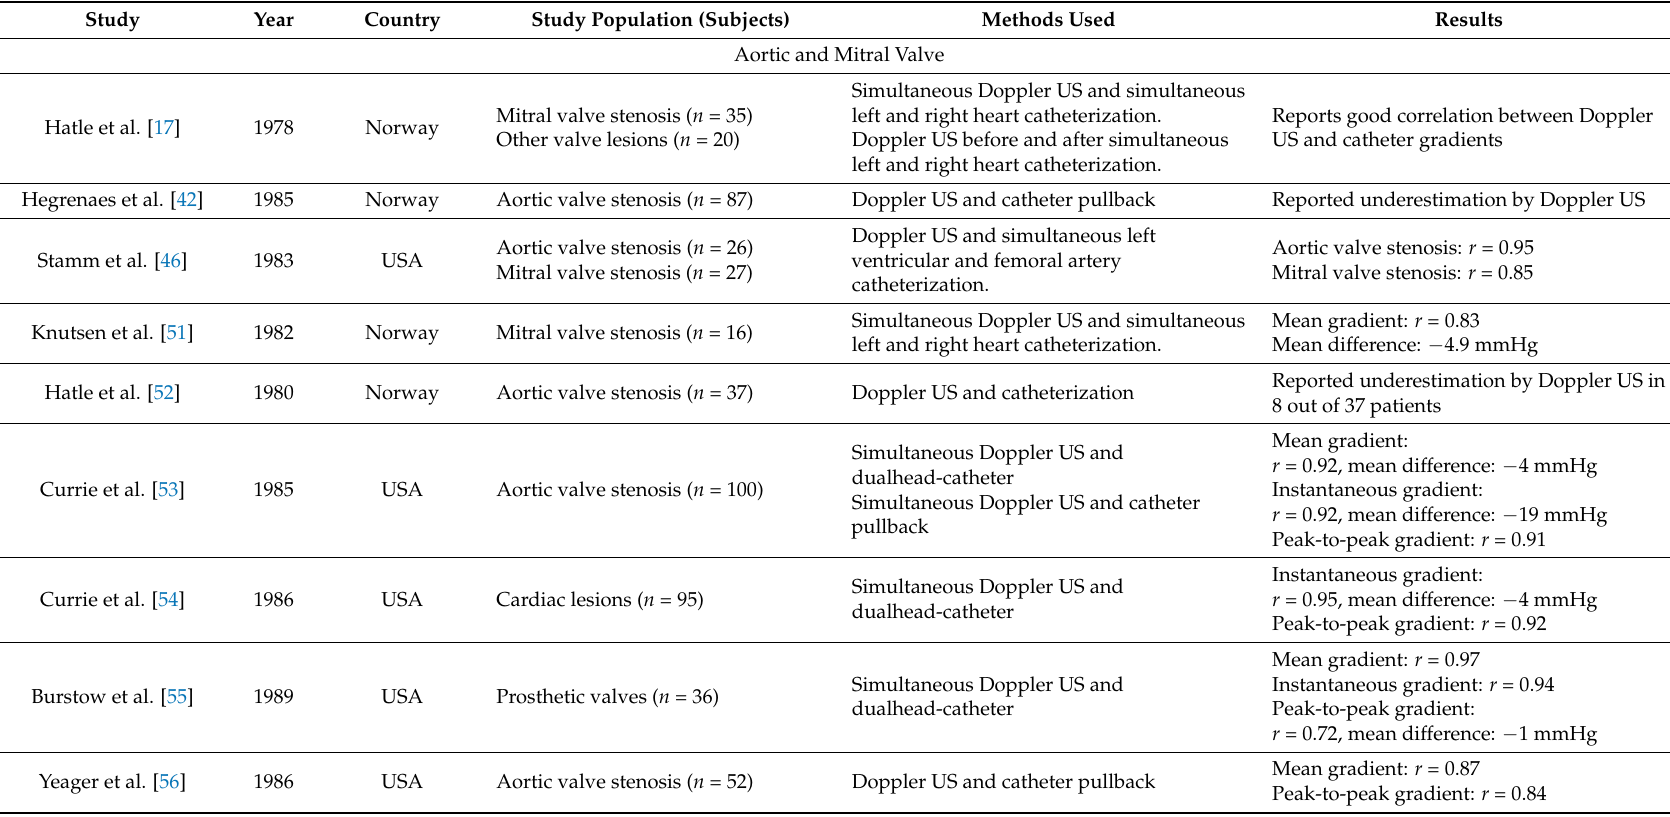
Table 1. Shows a list of included studies in this review. “Simultaneous Doppler US” involved Doppler US to be performed simultaneously with catheterization. “Instantaneous gradients” is the correlation between a maximum Doppler US or MRI derived pressure gradient compared with an invasive pressure gradient measured using a dual-head catheter, which allowed for simultaneous invasive pressure measurement before and after a stenosis. “Peak-to-peak” is the correlation between maximum Doppler US or MRI derived pressure gradient compared with an invasive pressure gradient measured between the peak pressures before and after a stenosis. “Peak gradient” did not clearly specify how invasive pressure gradients were measured. “Mean gradient” is the correlation between a Doppler US or MRI derived mean pressure gradient compared with an invasively measured mean pressure gradient. * A correlation coefficient for the post-treatment comparison was not